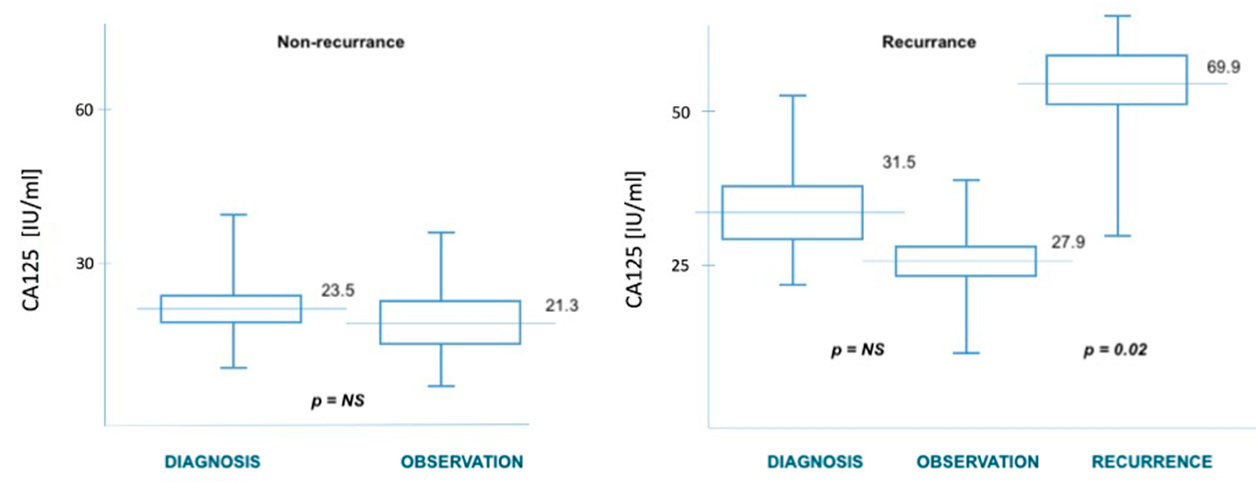
Figure 4. HE4 levels in relation to recurrence.